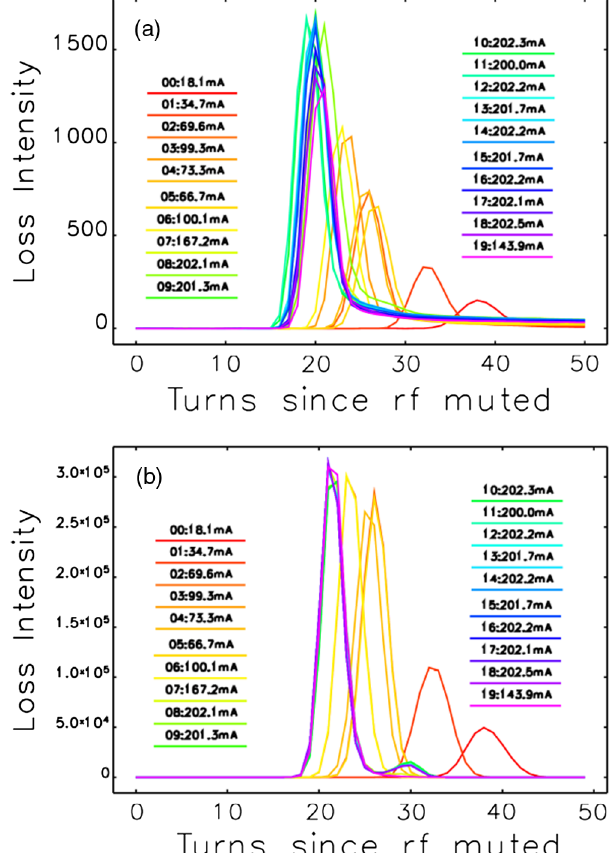
FIG. 16. Loss intensity profiles from (a) ID1 fast BLM and (b) PELEGANT modeling. Both ordinate axes are given in arbitrary units. The leading two-digit numbers in the legend correspond to the beam dump sequence numbers in Table